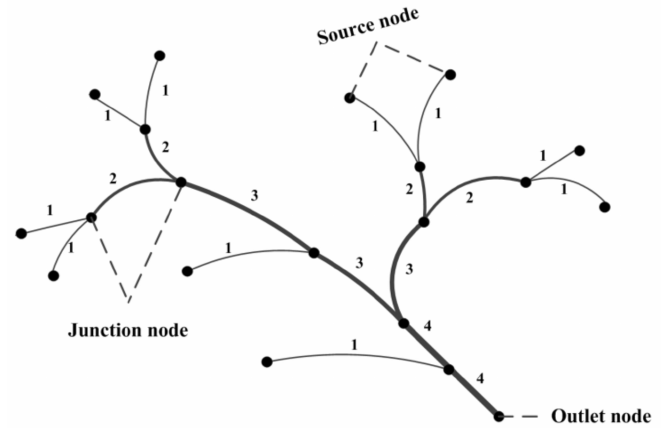
Figure 3. The three types of nodes in a river network. 1, 2, 3, and 4 in the figure are the river levels according to the Strahler stream order method